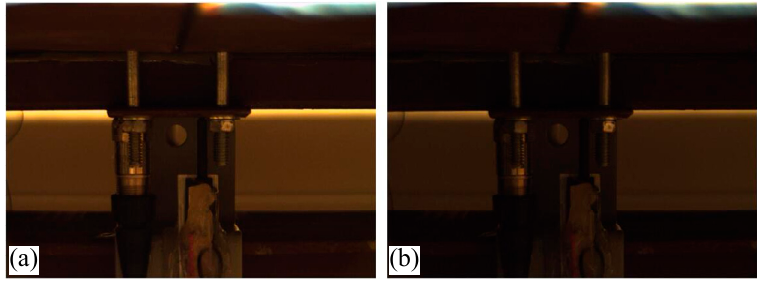
Figure 6. Illumination change. ( a ) 34 lux, ( b ) 18 lux.